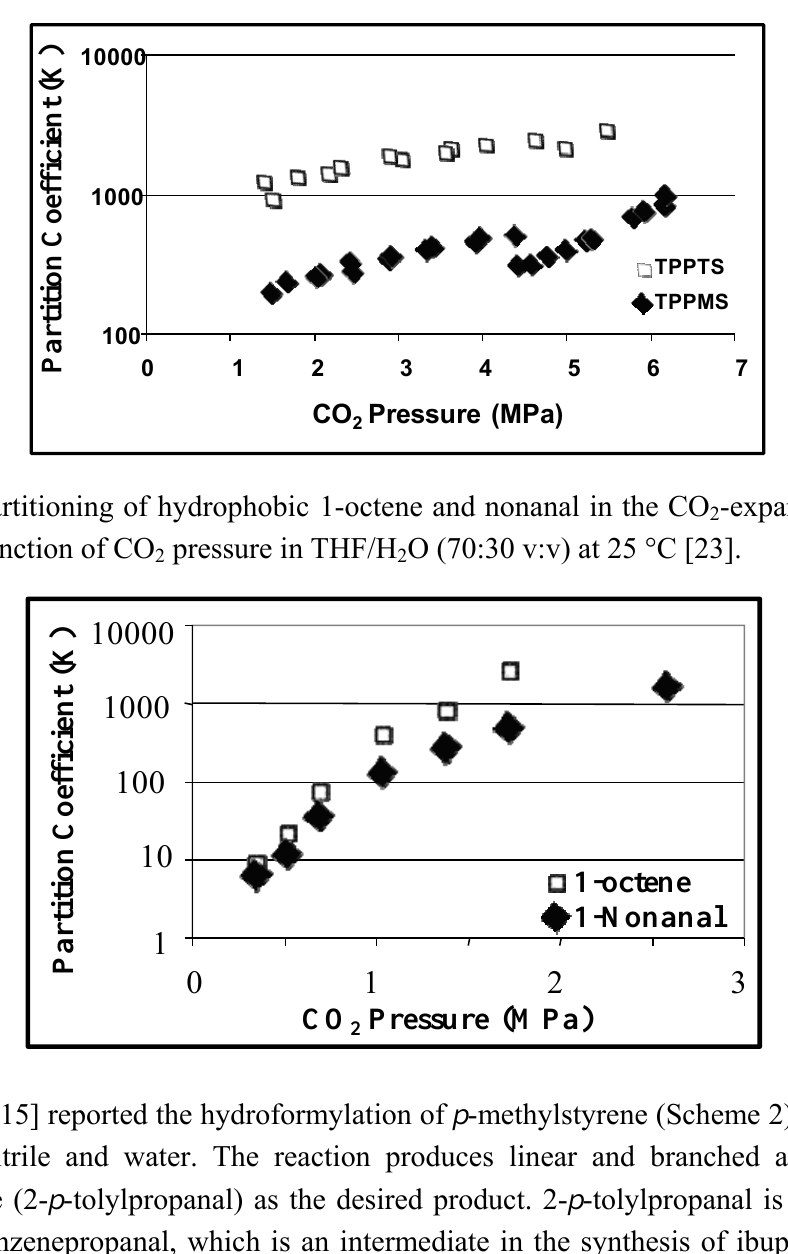
Figure 4. Partitioning of hydrophilic TPPMS and TPPTS in the aqueous phase as a function of CO pressure in THF/H O (70:30 v:v) at 25 °C [23]. 2 2